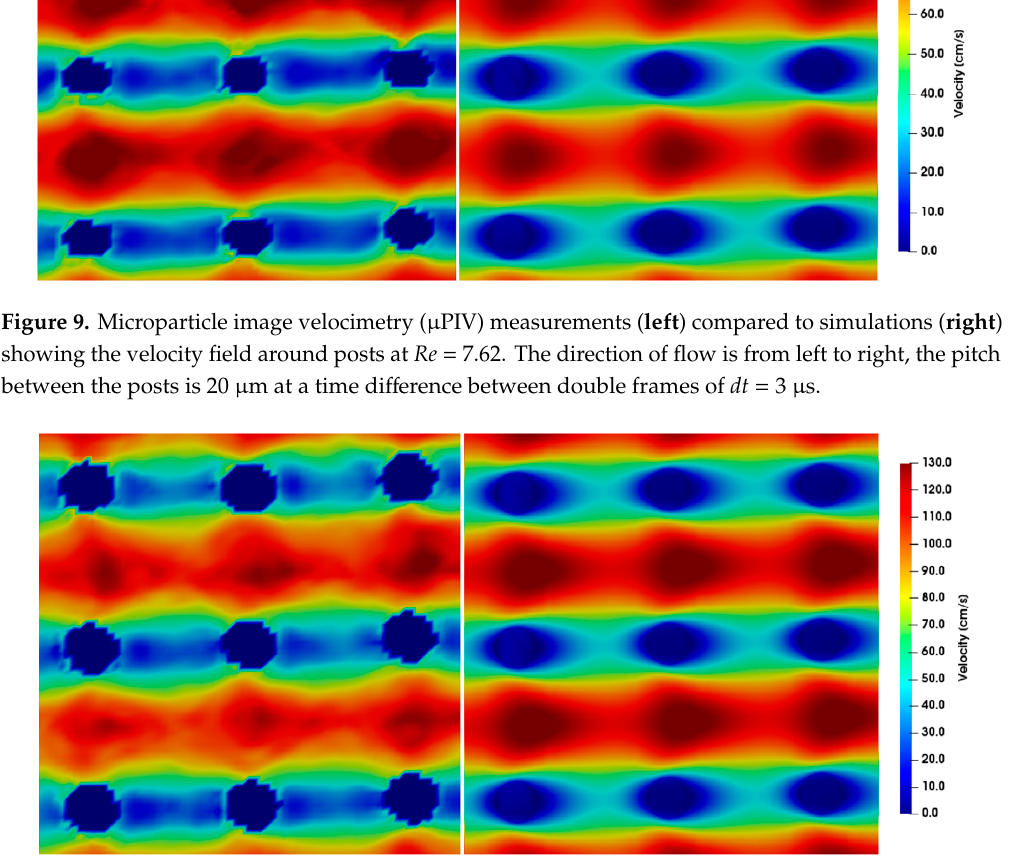
Figure 10. µ PIV measurements ( left ) compared to simulations ( right ) showing the velocity field around posts at Re = 11.43. The direction of flow is from left to right, the pitch between the posts is 20 µ m and the time di ff erence between double frames is dt = 1 µ